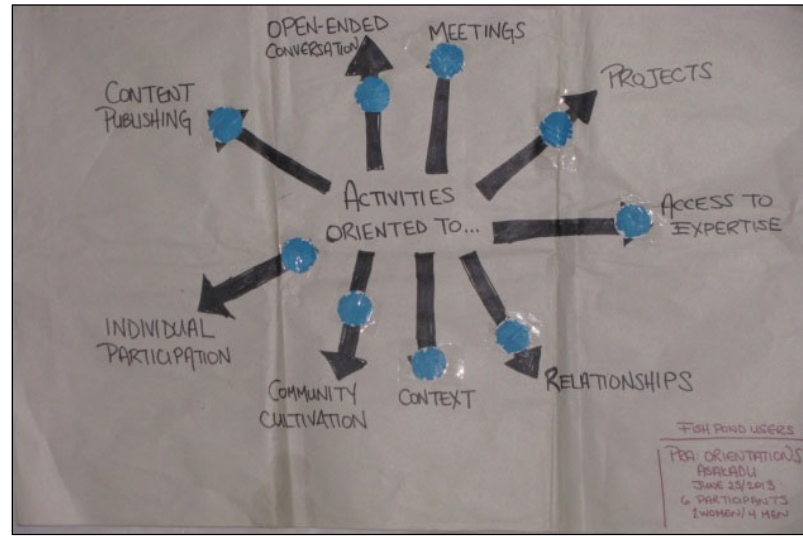
Figure 5. Orientations Participatory Rural Appraisal (PRA) Diagram with Fish Farmers in